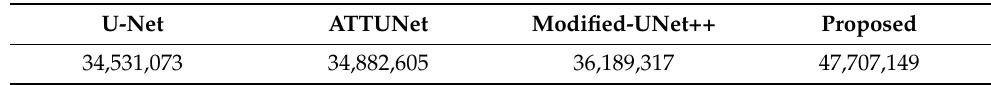
Table 9. Number of parameters for each architecture.